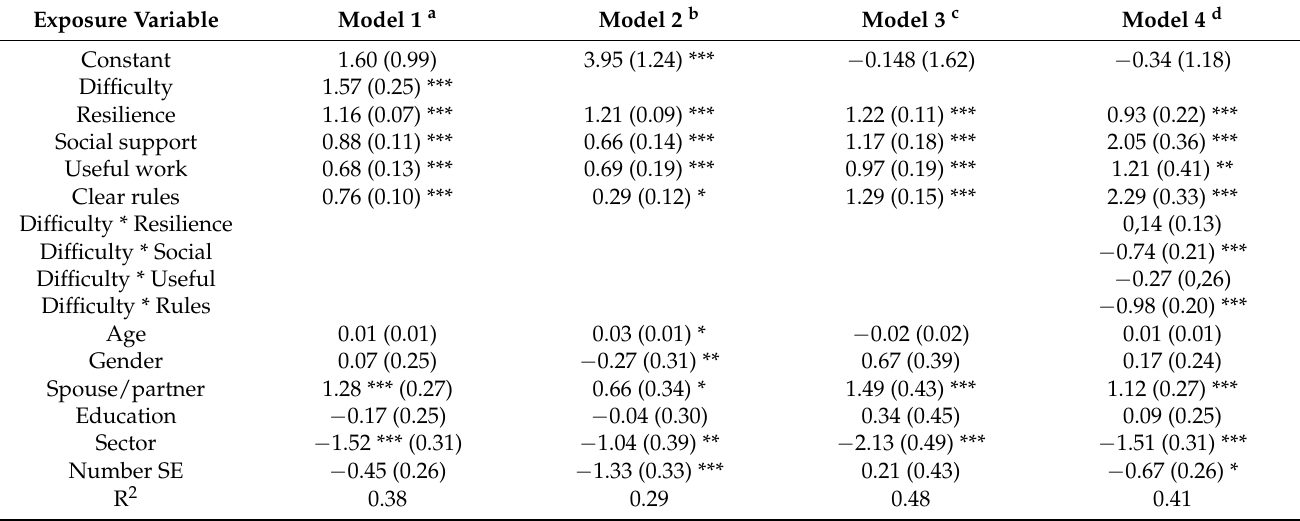
Table 4. OLS Regressions for Well-being, Difficulty, SEM variables and Covariates (Unstandardised B-coefficients, Standard error in